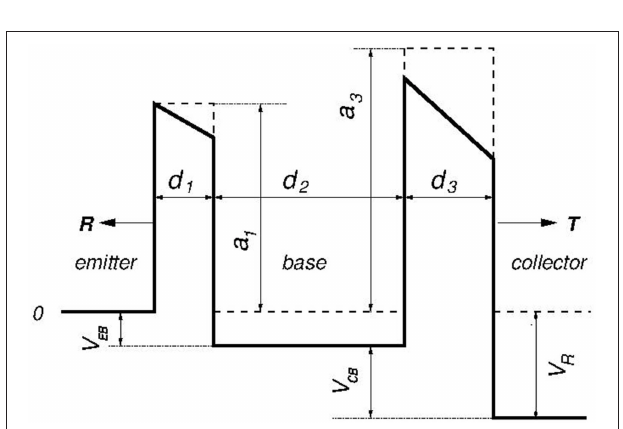
FIGURE 5 | Schematics of typical transistor, where notations correspond to V EB Equations (73) and (74) for N 3 and ε 1 with replacement: b 1 = = → − V CB (collector-to-base voltage). (emitter-to-base voltage) and b 3 → − a 1 , V 1,1 a 1 V EB ( a 1 > 0), Potential values at layer edges are V 1,0 = = − V 2,1 V 2,2 V EB and V 3,2 a 3 V EB , V 3,3 a 3 V R ( a 3 > 0). Polarity = = − = − = + is shown to be positive (left-to-right electron flow, V EB , V CB >